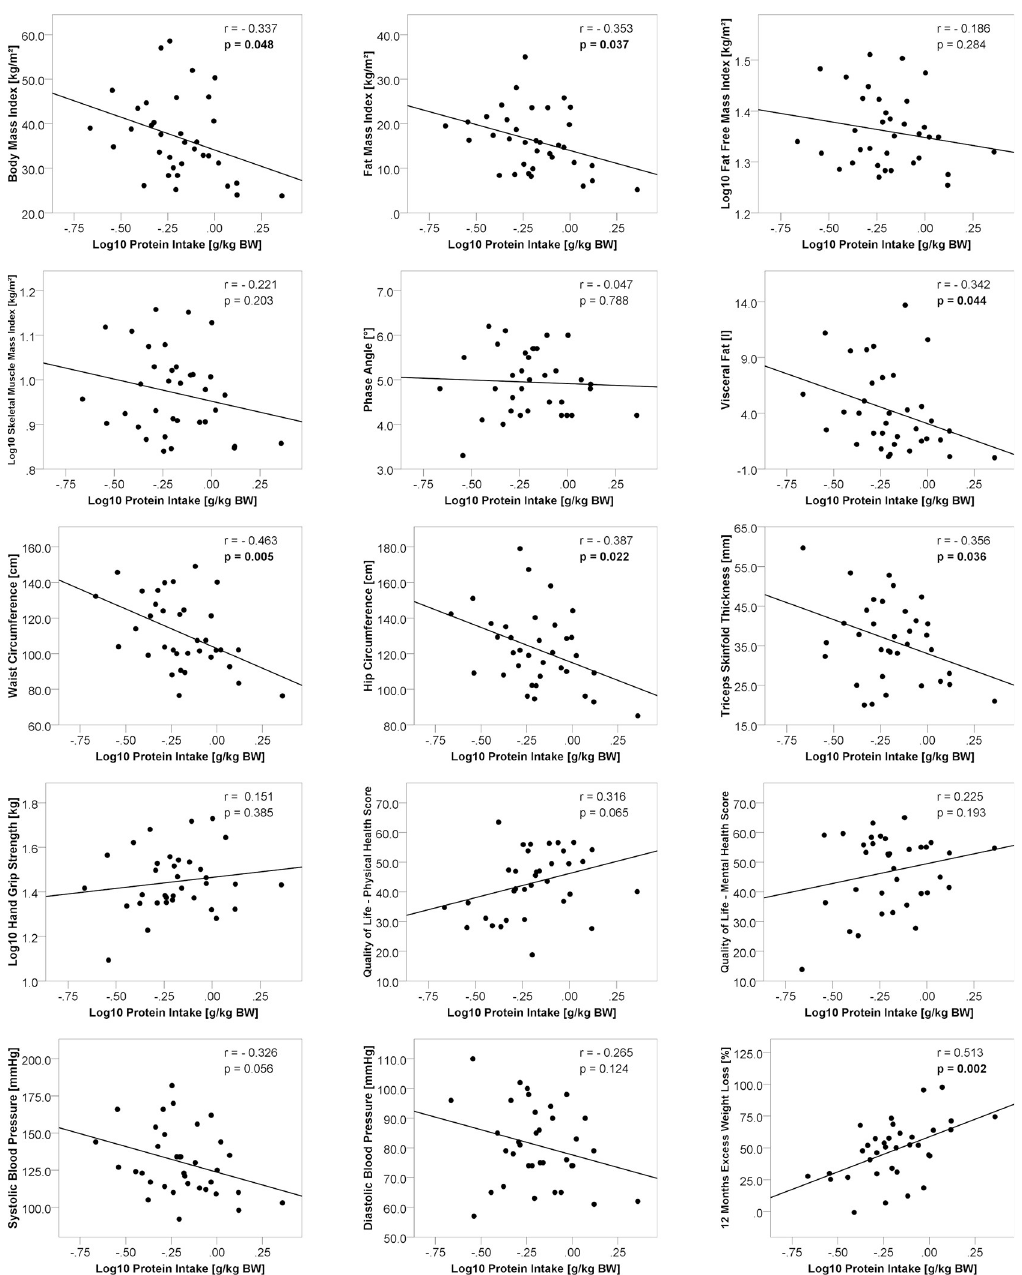
Fig 2. Pearson correlation between protein intake and clinical outcome